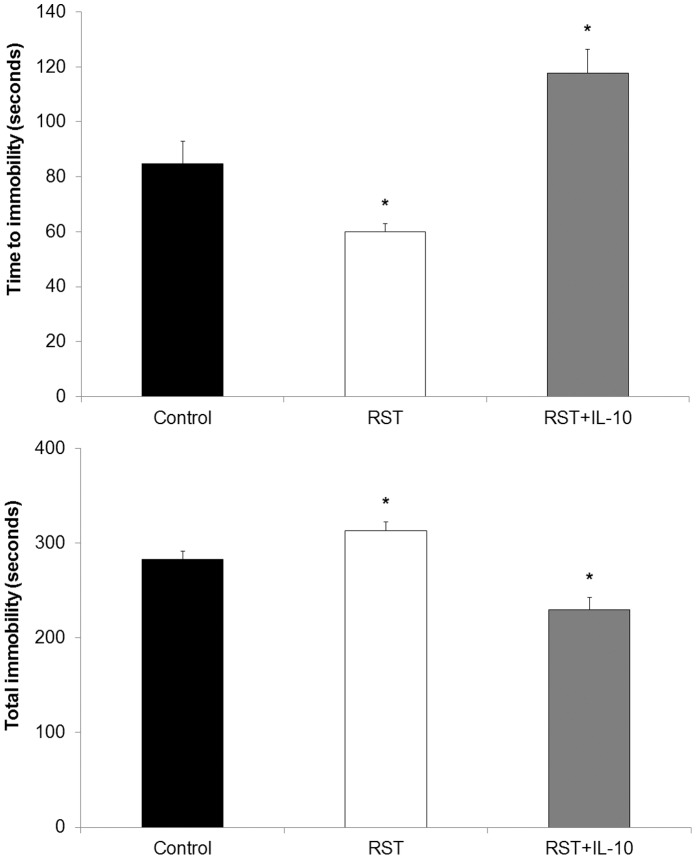
IL-10 treatment exhibits a rescuing effect on restraint stress-induced behavioral deficits.As part of a 21-day RST protocol, mice were treated with vehicle (control and RST mice) or murine IL-10 (IL-10 mice) for seven days immediately preceding FST. For each data point n = 5–15 individuals. Data shown is mean +SEM. *p<0.05.